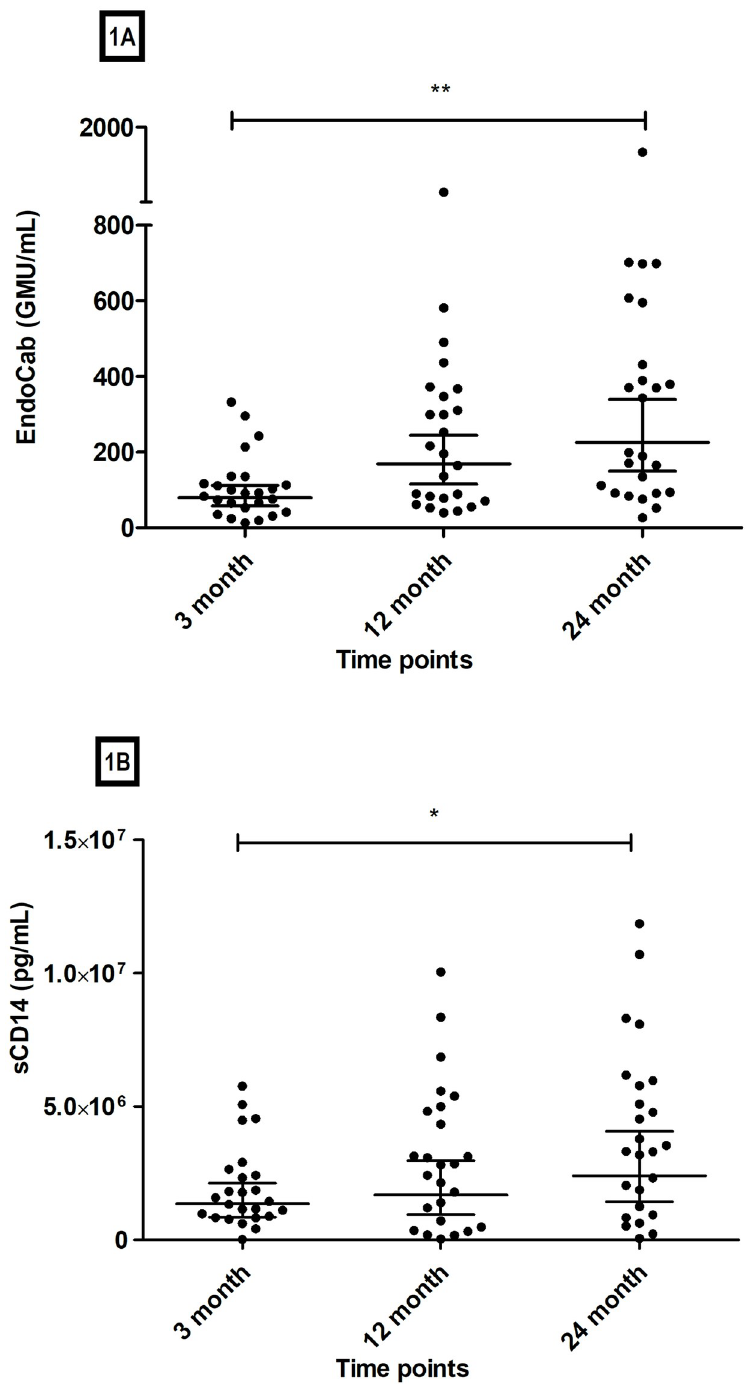
Fig 1. Levels of EndoCab and sCD14 at different time points (n = 25). Y-axis indicates EndoCab levels (1A) and sCD14 levels (1B), while X-axes indicate time points after birth (1A and 1B). Each single dot represents an individual EndoCab level (GMU/mL) (1A) and sCD14 level (pg/mL) (1B) at that time point. The horizontal bars denote the geometric mean values, and the error bars represent the 95% confidence intervals (CI). We performed the Kruskal- Wallis test for statistical evaluation [ �� P = 0.001(1A) and � P < 0.05 (1B)].